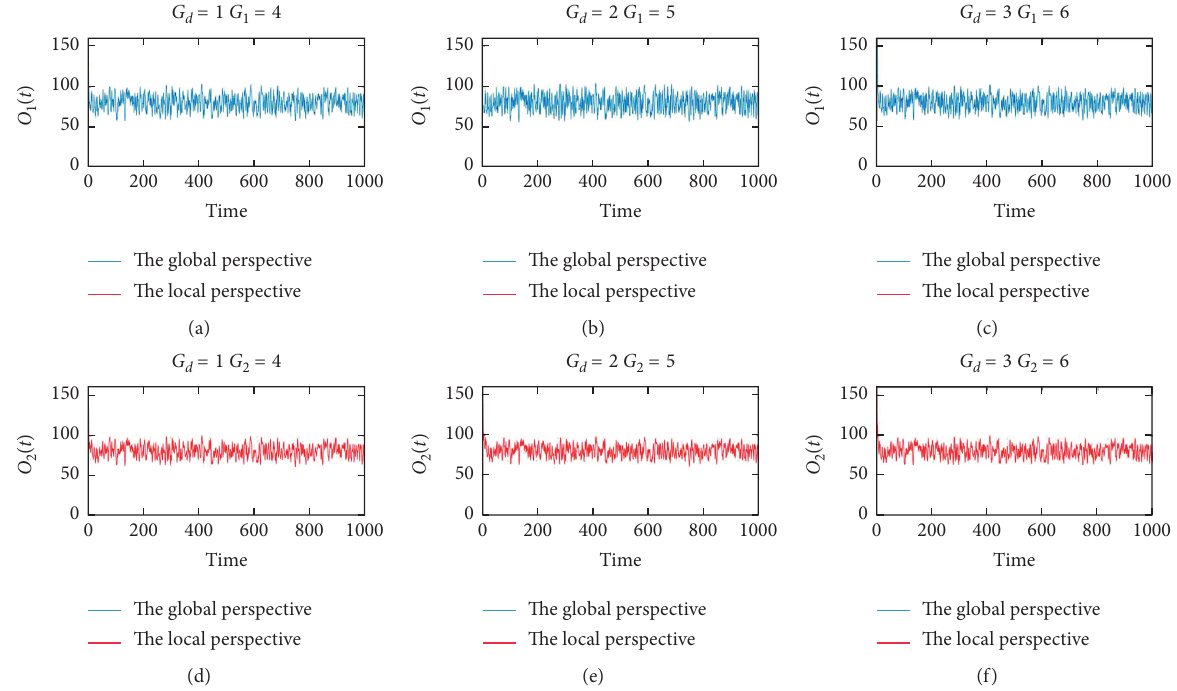
Figure 27: The production fluctuation under the scenario of random demand obeying uniform distribution from different perspectives.